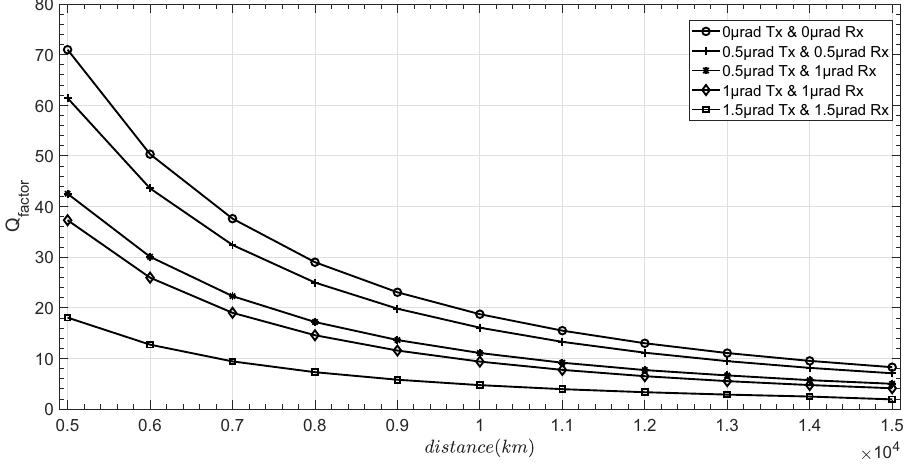
Figure 13: Quality factor ( Q factor ) as a function of distances between satellites for di ff erent transmitter and receiver pointing errors.